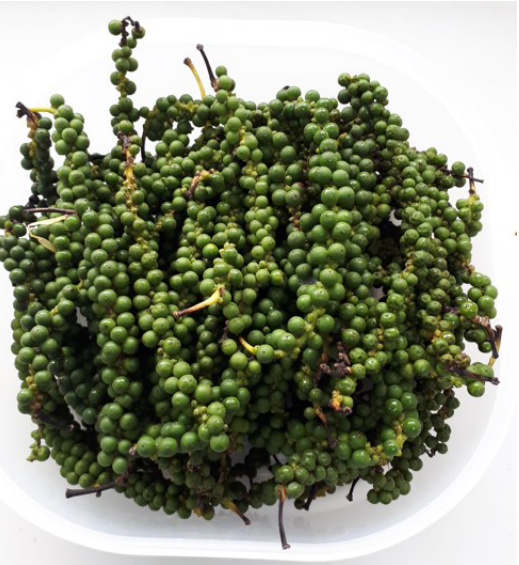
Figure 2. Piper nigrum L. fruit used in this study.